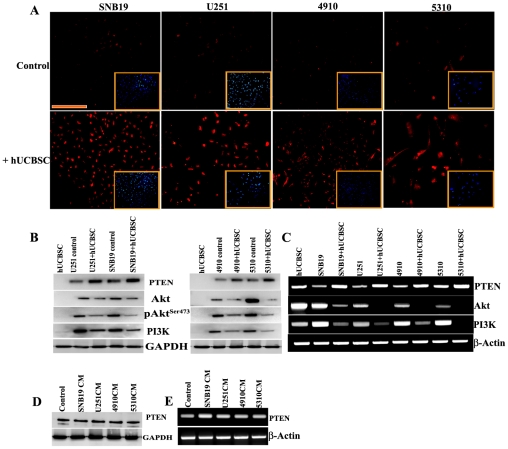
Upregulation of PTEN in hUCBSC-treated co-cultures of glioma cells.(A) Fluorescent microscopic images demonstrate PTEN expression (red fluorescence). SNB19, U251, 4910 and 5310 cells were co-cultured with hUCBSC for 3 days and processed for immunofluorescence. Immunostaining was performed with Alexa flour-594 conjugated PTEN antibodies. All sections were stained with DAPI to show nuclear localization. Insets show DAPI. n ≥ 3. Scale bar  = 100 µm. (B) Equal amounts of protein (40 µg) from single cultures and co-cultures were loaded onto 12% SDS gels and transferred onto nitrocellulose membranes, which were then probed with respective antibodies. GAPDH was used as a positive loading control. (C) Reverse transcription-based PCR analysis of PTEN, Akt and PI3K in co-cultures. β-actin was used as a positive loading control. Each blot and gel is representative of experiments performed in duplicate with each sample (n = 3). hUCBSC were grown in conditioned media from hUCBSC (control), SNB19, U251, 4910 and 5310 conditioned media for 3 days and the lysates (80 µg for each lane) were subjected to (D) Western analysis for PTEN or (E) Reverse-transcription based PCR analysis. CM =  conditioned medium.